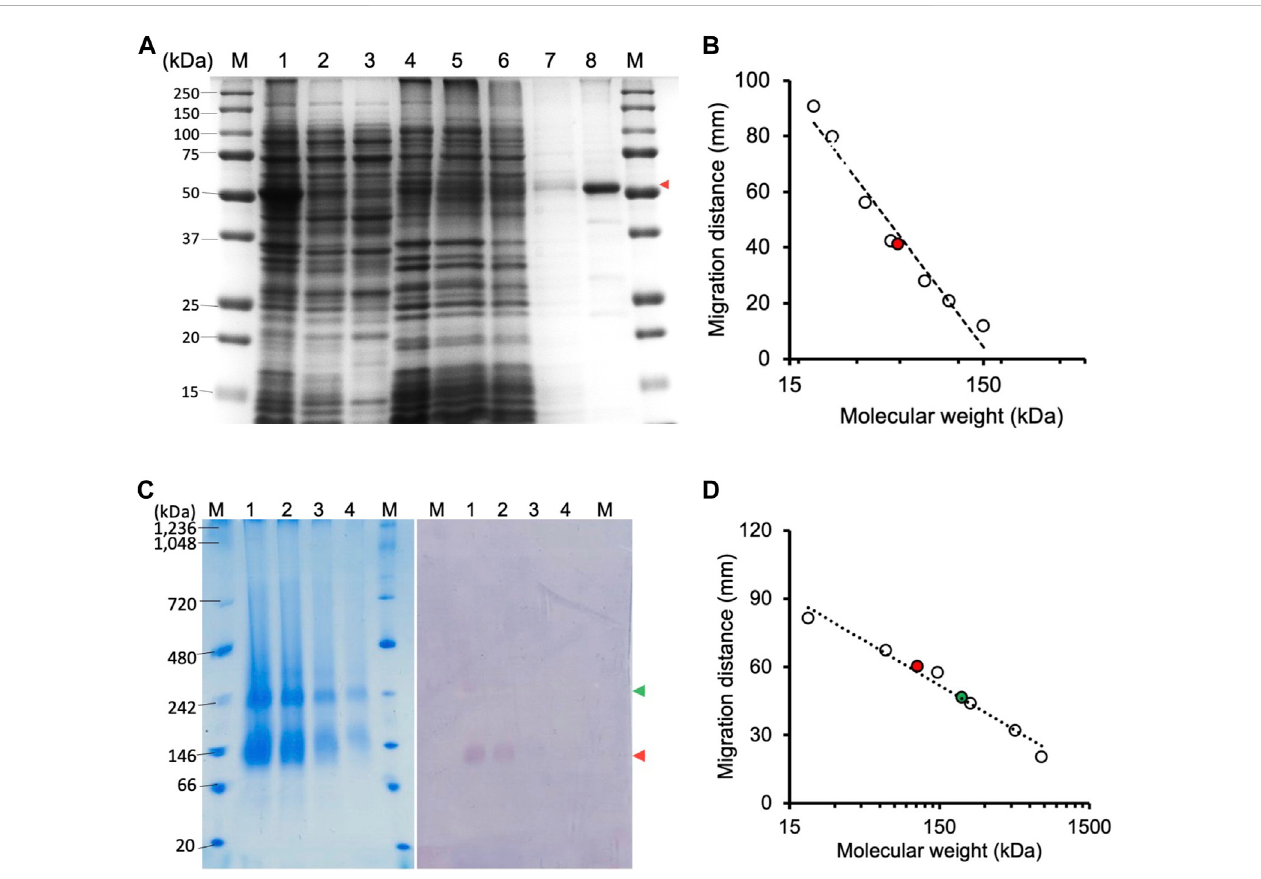
FIGURE 1 Electrophoresis of CjMQO. (A) SDS-PAGE analysis of different steps of CjMQO puri fi cation (expected size 54 kDa). Lane M, marker (6 μ g); Lane 1, Lysate (10 μ g);Lane2, Clari fi edlysate(10 μ g);Lane 3,Cytosol(10 μ g);Lane4, Membranefractions(10 μ g);Lane 5,Flowthrough(10 μ g);Lane 6,Concentrated Wash A(10 μ g);Lane7,ConcentratedWashB(0.1 μ g);andLane8,Concentratedeluate(1 μ g).TheredarrowindicatesthebandcorrespondingtoCjMQO. (B) Semi- logarithmic plot of migration distance used to calculate the molecular weight of CjMQO under denaturation conditions. (C) Coomassie brilliant blue staining on a high-resolution clear native electrophoresis (hrCNE) gel of puri fi ed CjMQO (left) and in-gel activity staining of puri fi ed CjMQO (right). Lane M, Marker (5 μ g) and puri fi ed CjMQO: Lane 1 (3 μ g); Lane 2 (2 μ g); Lane 3 (1 μ g); and Lane 4 (0.5 μ g). The red and green arrows indicate the location corresponding to the dimer and tetramer of CjMQO, respectively. (D) Semi-logarithmic plot of migration distance for calculating the molecular weight of CjMQOs under native